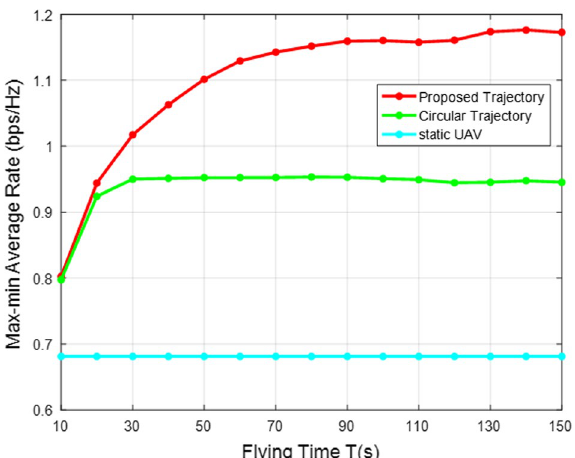
Fig. 4 The max–min average rate versus period